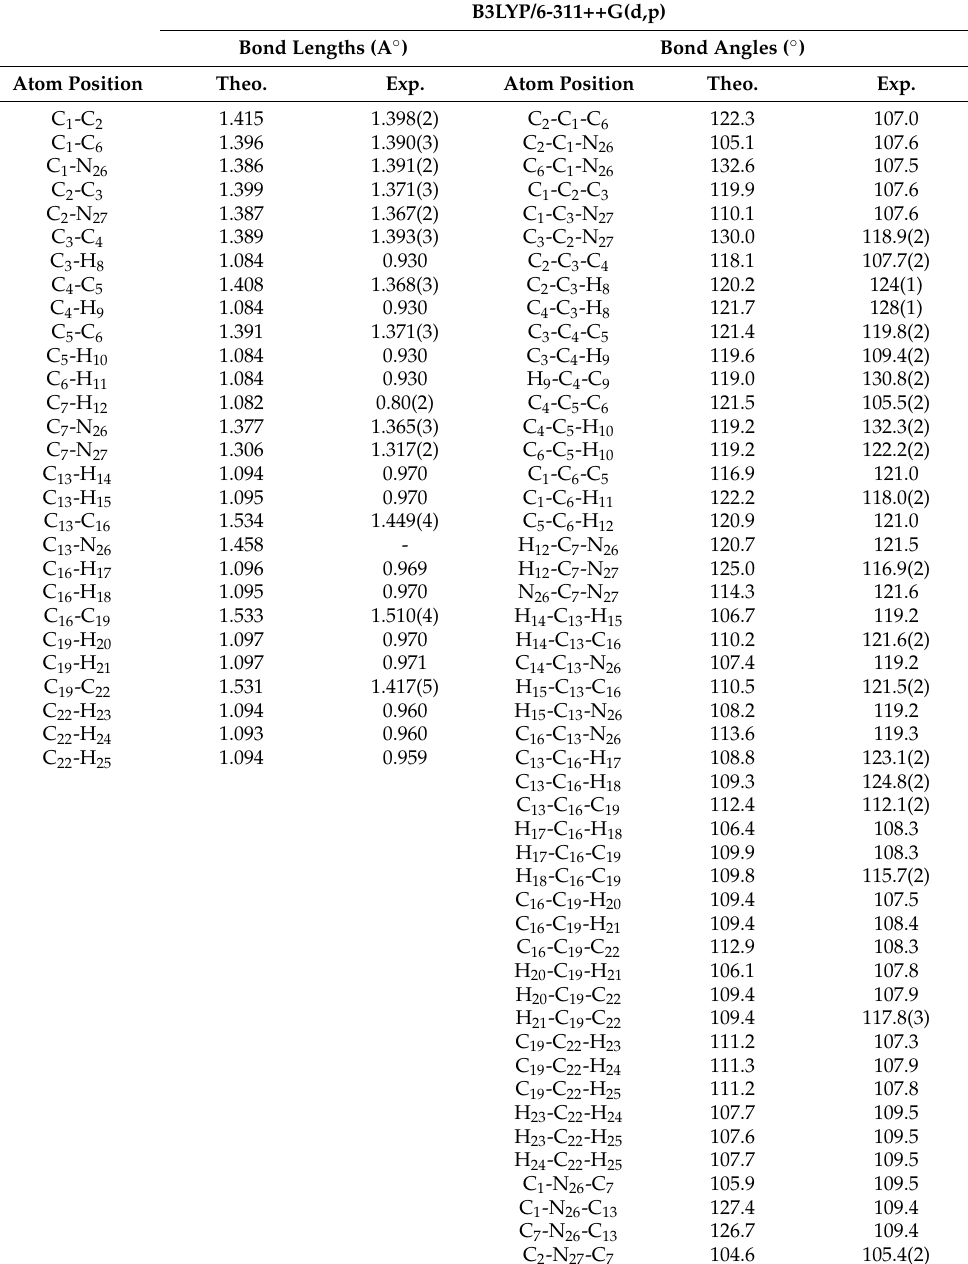
Table 1. The theoretical and experimental optimized structural parameters of